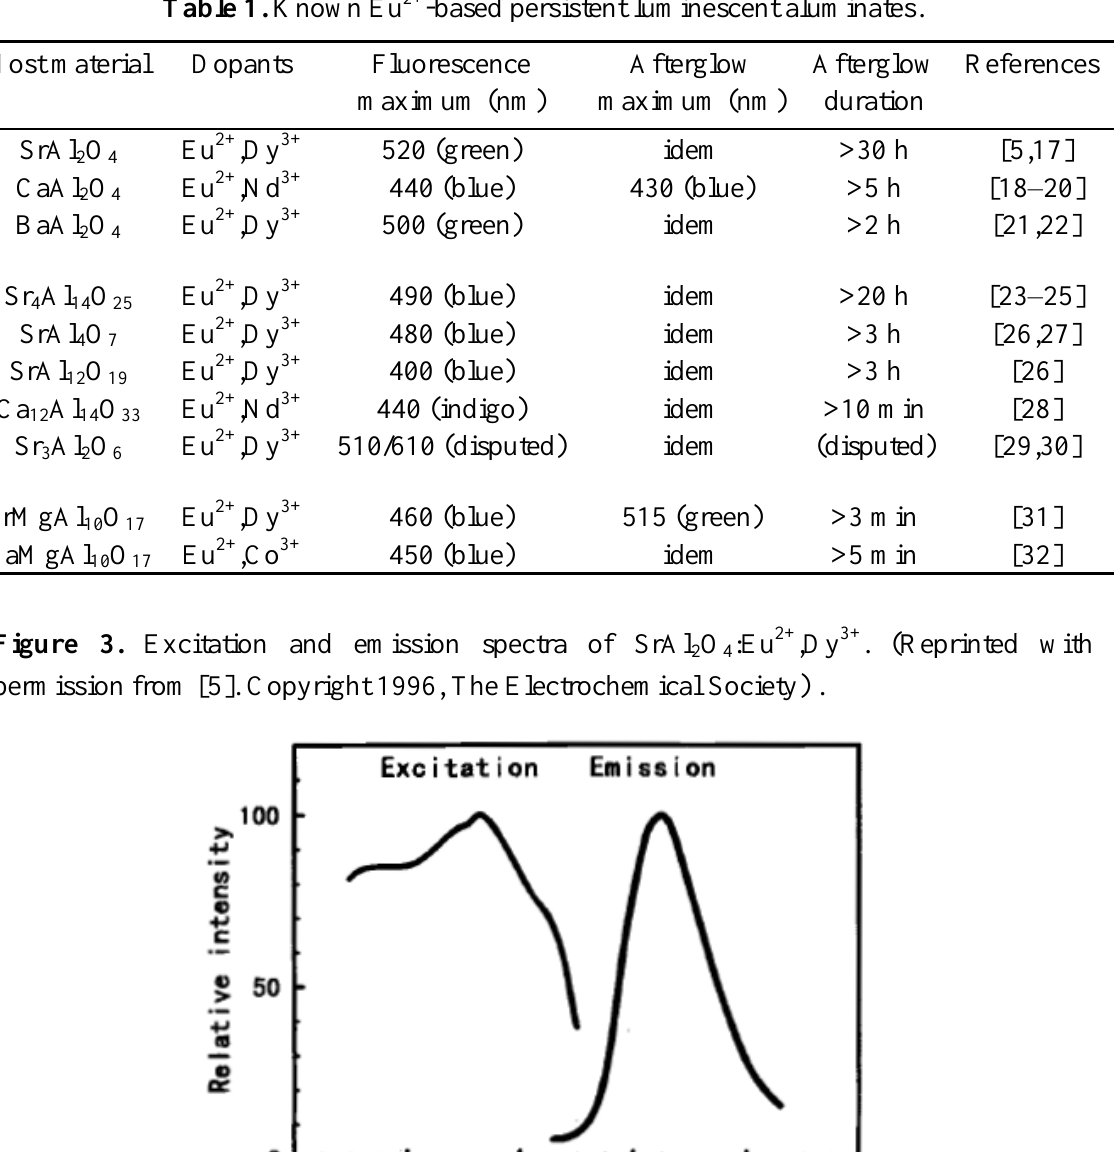
Table 1. Known Eu 2+ -based persistent luminescent aluminates.